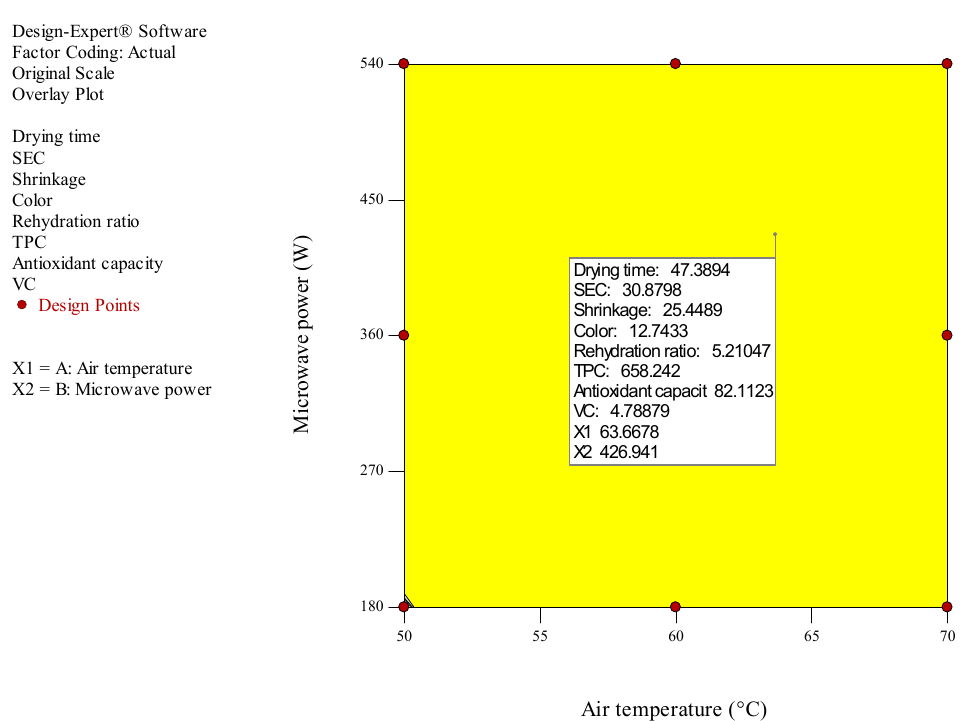
Figure 10. The values of individual desirability of input and response parameters for MCD.